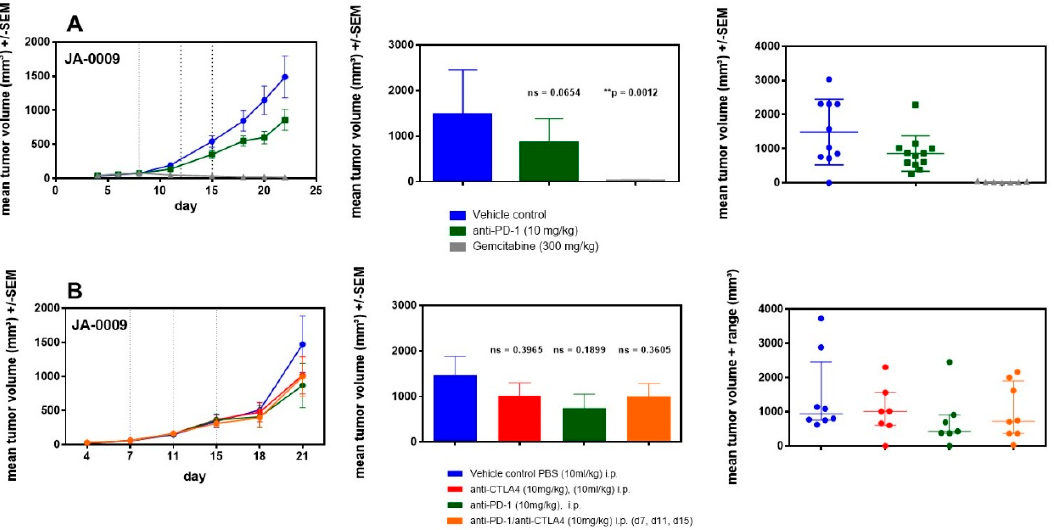
Figure 6. ( A ). Two independent efficacy studies with chemotherapeutic gemcitabine or antibodies against the inhibitory checkpoint molecules mPD-1 and mCTLA-4 in the sMDI JA-0009 tumor model. Efficacy study of the sMDI JA-0009 tumor model characterized the effects of antibodies against the immune checkpoint inhibitor mPD-1 as well as gemcitabine as a chemotherapeutical agent. ( B ). In the second study treatment, the effects of antibodies against the immune checkpoint inhibitor mPD-1, mCTLA-4, or both were tested. Mice were randomized on day 7. Dotted lines show the timepoints of treatment. Results are shown as growth curves (curve chart), mean of groups (bar graphs), and individual values of a single mouse per group at the study termination (dot plots). Probability ( P ) was tested with the parametric unpaired t -test (GraphPad Prism 5.04, GraphPad Software, San Diego, CA 92108, USA) compared to PBS vehicle control. Differences were determined as not significant with ns > 0.050 and significant with * p < 0.050, ** p < 0.010, or *** p < 0.001.